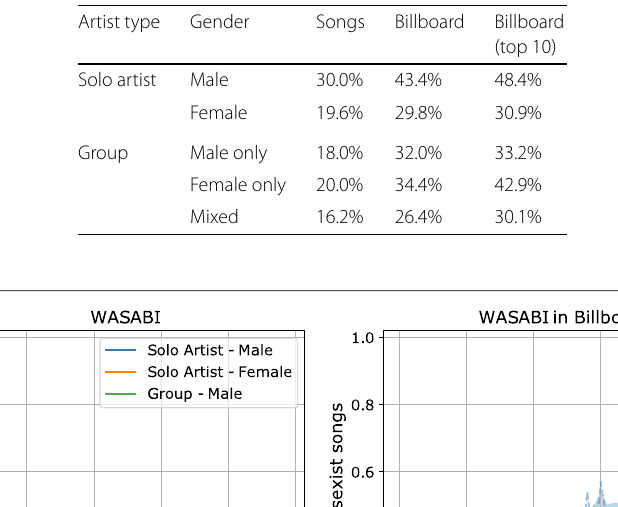
Table 2 Percentage of songs containing sexist passages identified for each artist type and gender. Percentages correspond to the fraction of sexist lyrics within the artist type and gender